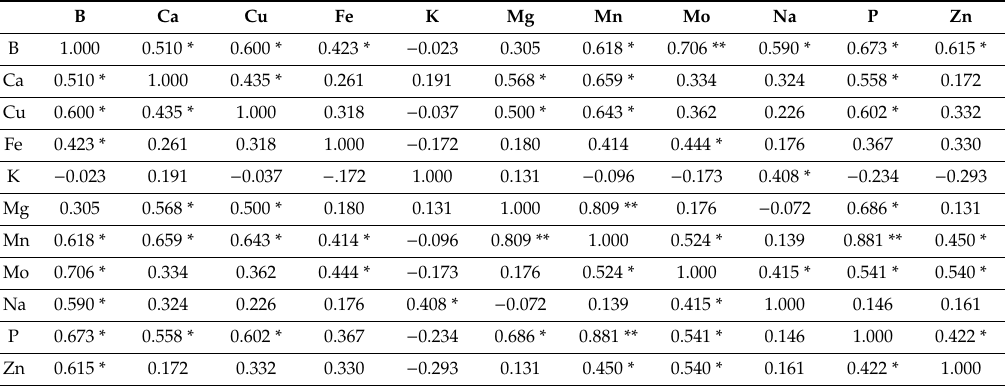
Table 2. Correlation matrix for elements in the rind. Statistical analysis was performed using SPSS 25.0.0.1. Correlations greater than 0.900 were considered very strong and are marked with ***. Correlations between 0.700 and 0.899 were considered strong correlation and are marked with **. Correlations between 0.400 and 0.699 were considered moderate correlation and are marked with *. Correlations between 0 and 0.399 were considered weak correlation and are not marked. The KMO test score was 0.753. Bartlett’s test score was 0. Each element corresponds to independent measurements and 108 individual